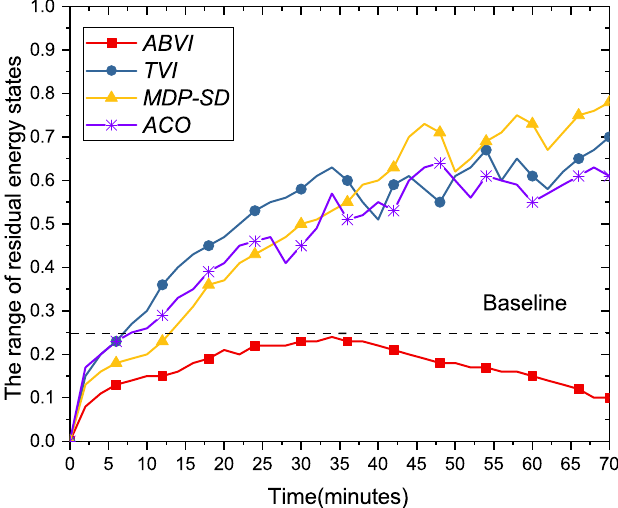
Figure 10. The range of residual energy state versus